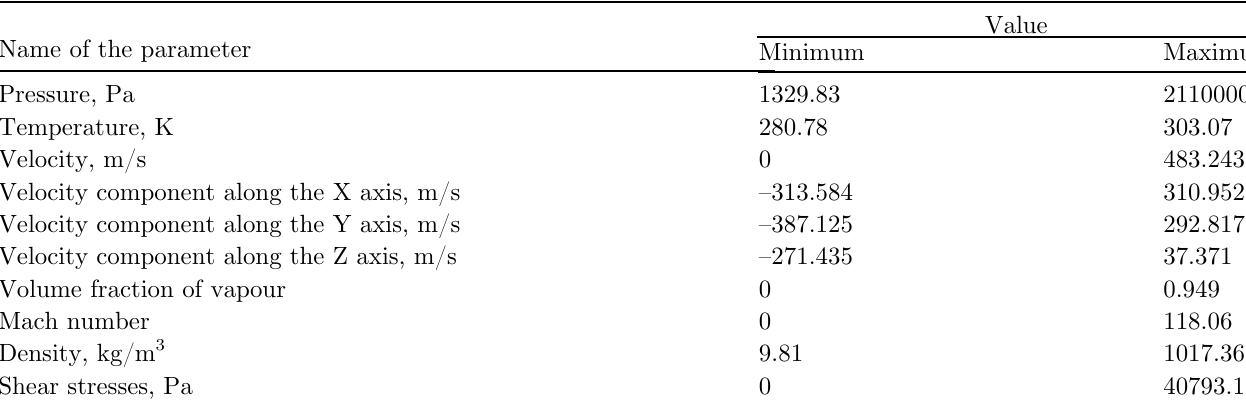
Fig. 8. Comparison of experimental and numerical simulation results. Table 3. Results of numerical simulation of cavitation